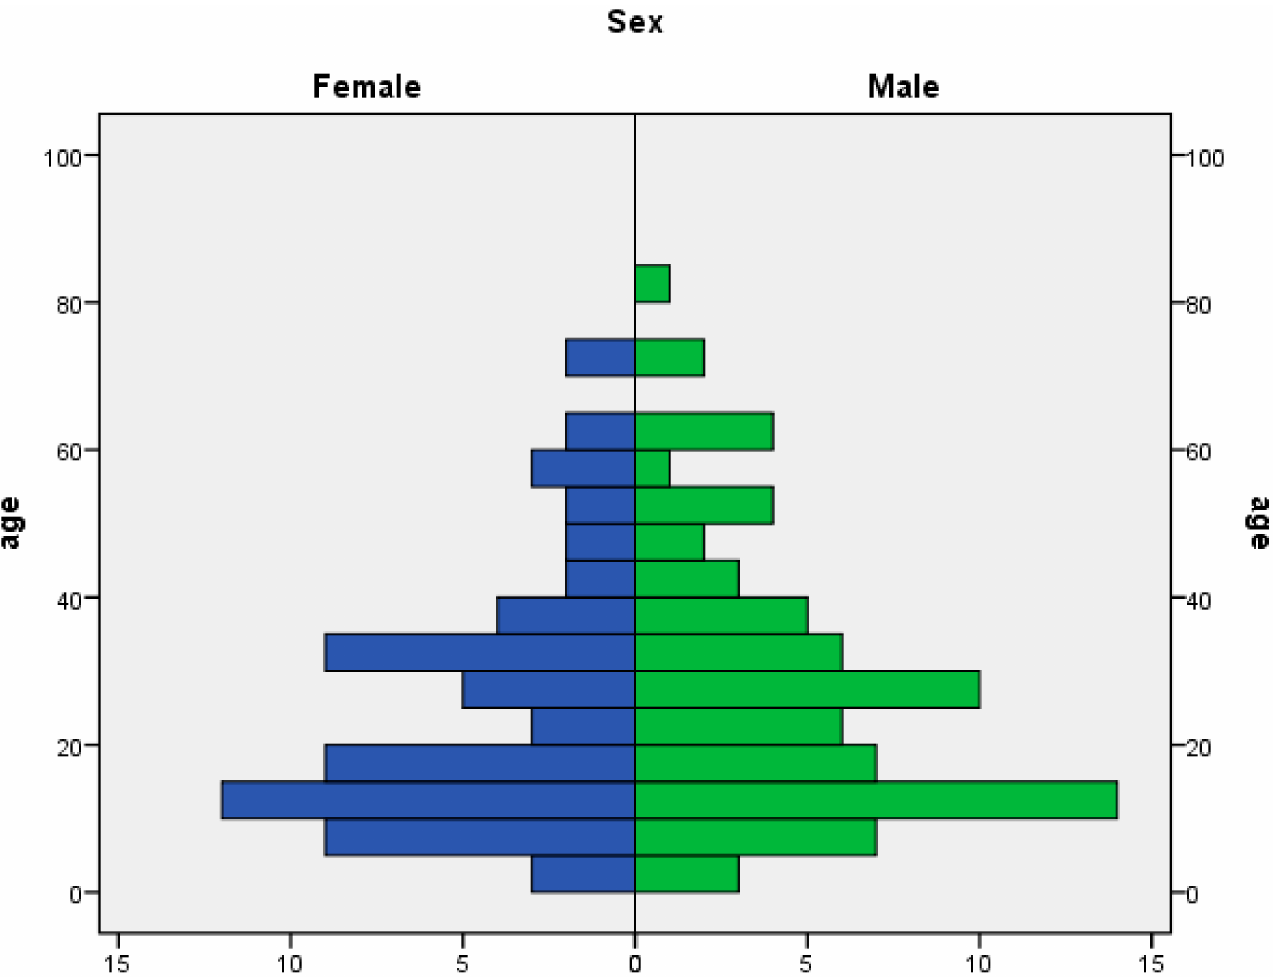
Figure 2. Distribution of cases by age and